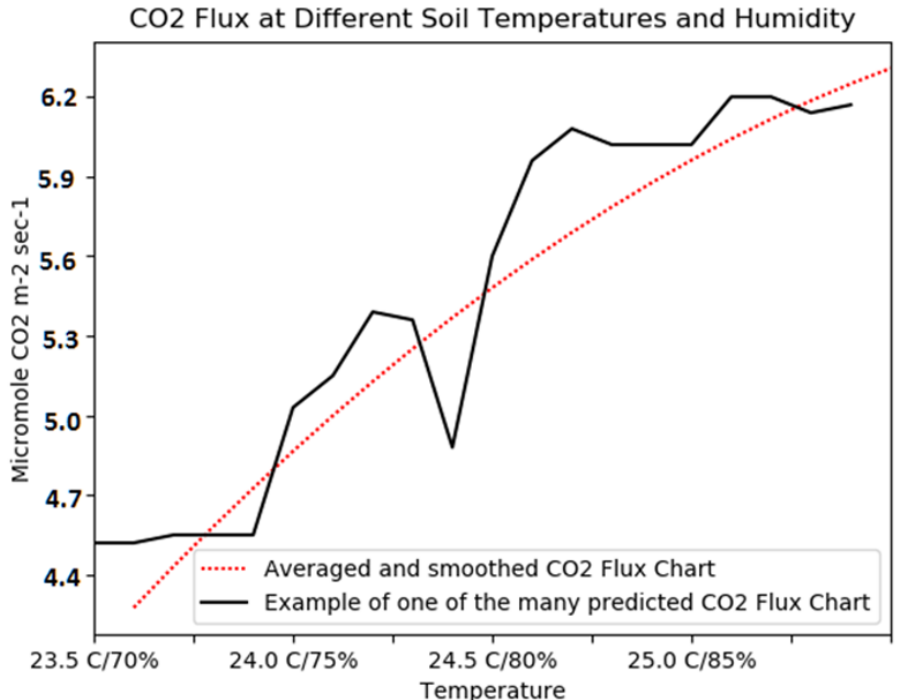
Figure 7. Results of experiment 6. Dependence of CO 2 flux rate on soil temperature. The main point is the “Averaged and Smoothed CO 2 Flux” Chart. This function describes the tendency of the Soil _ CO 2_ Flux SA ( T ) value to change with temperature } values. The averaged over a set of auxiliary parameter { ( rH , Soil _ Type ( X )) i